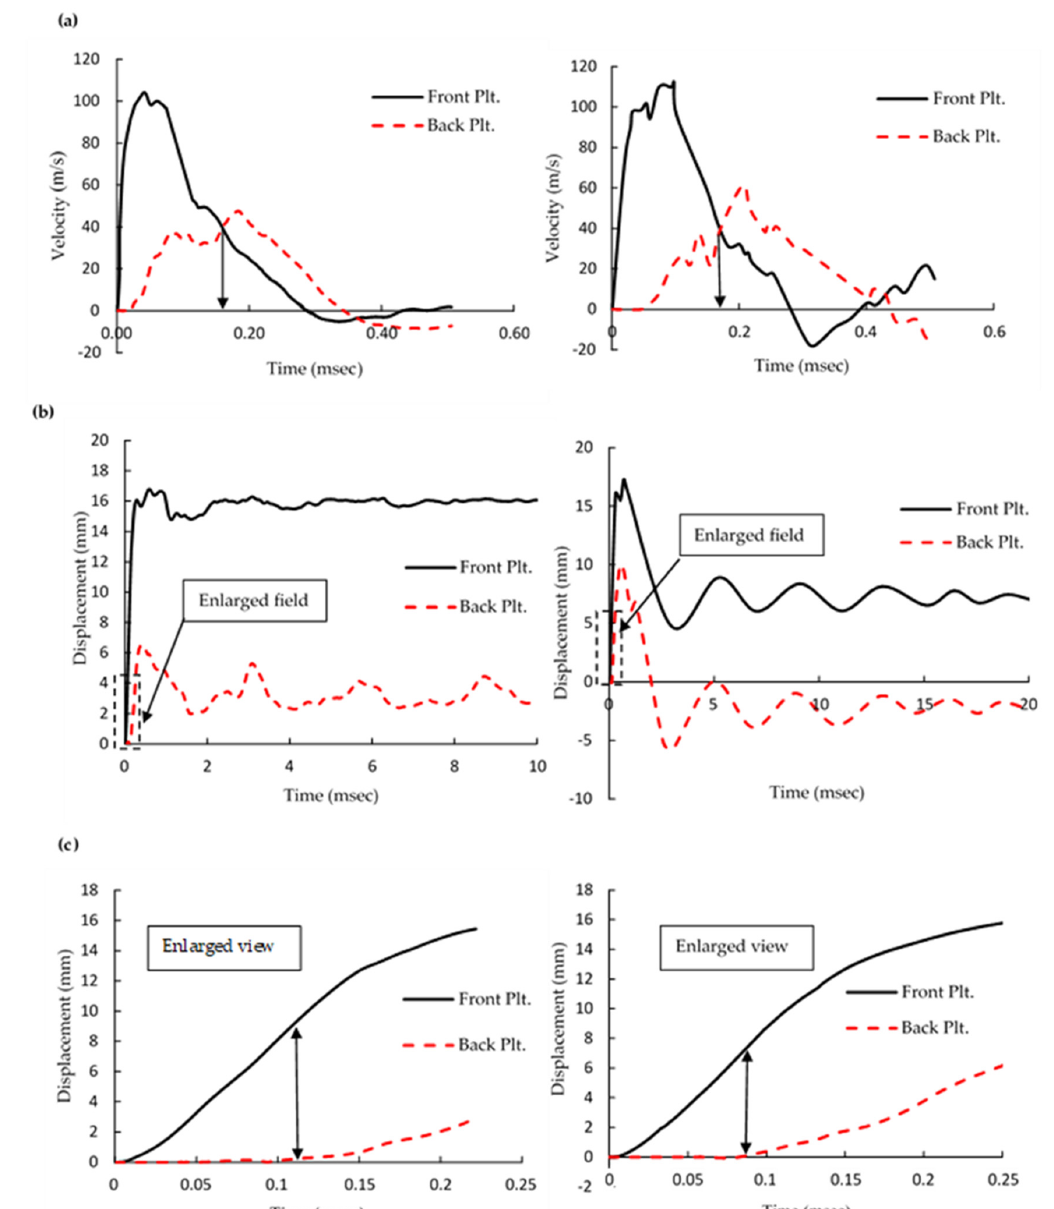
Figure 8. ( a ) Velocity and ( b ) displacement–time histories for the facing sheets at midspan. ( c ) Enlarged view for displacement–time histories within (0–0.25 msec) time interval, TZRC (left column) and TRC (right column).